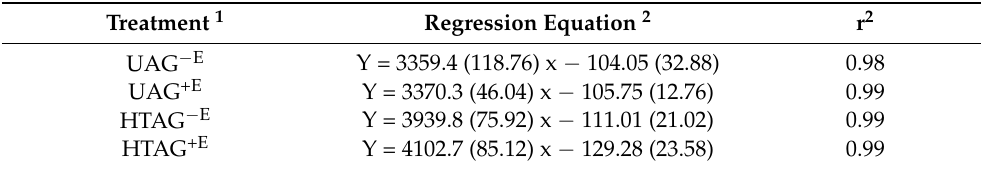
Table 5. Regression equations relating UAG ± E - and HTAG ± E -associated AME n content to intake of